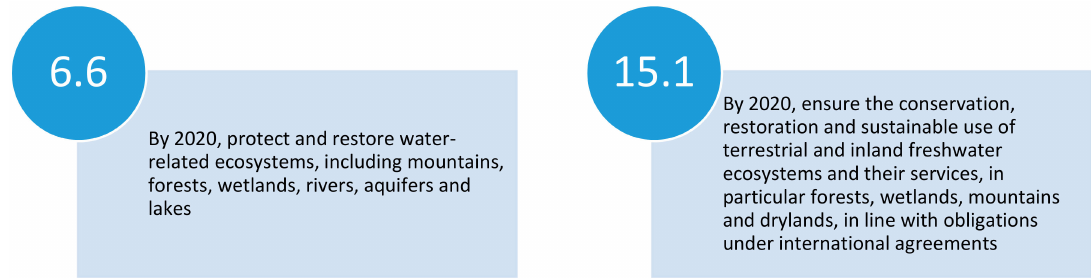
Figure 2. Sustainable Development Goal (SDG) targets related to forests and